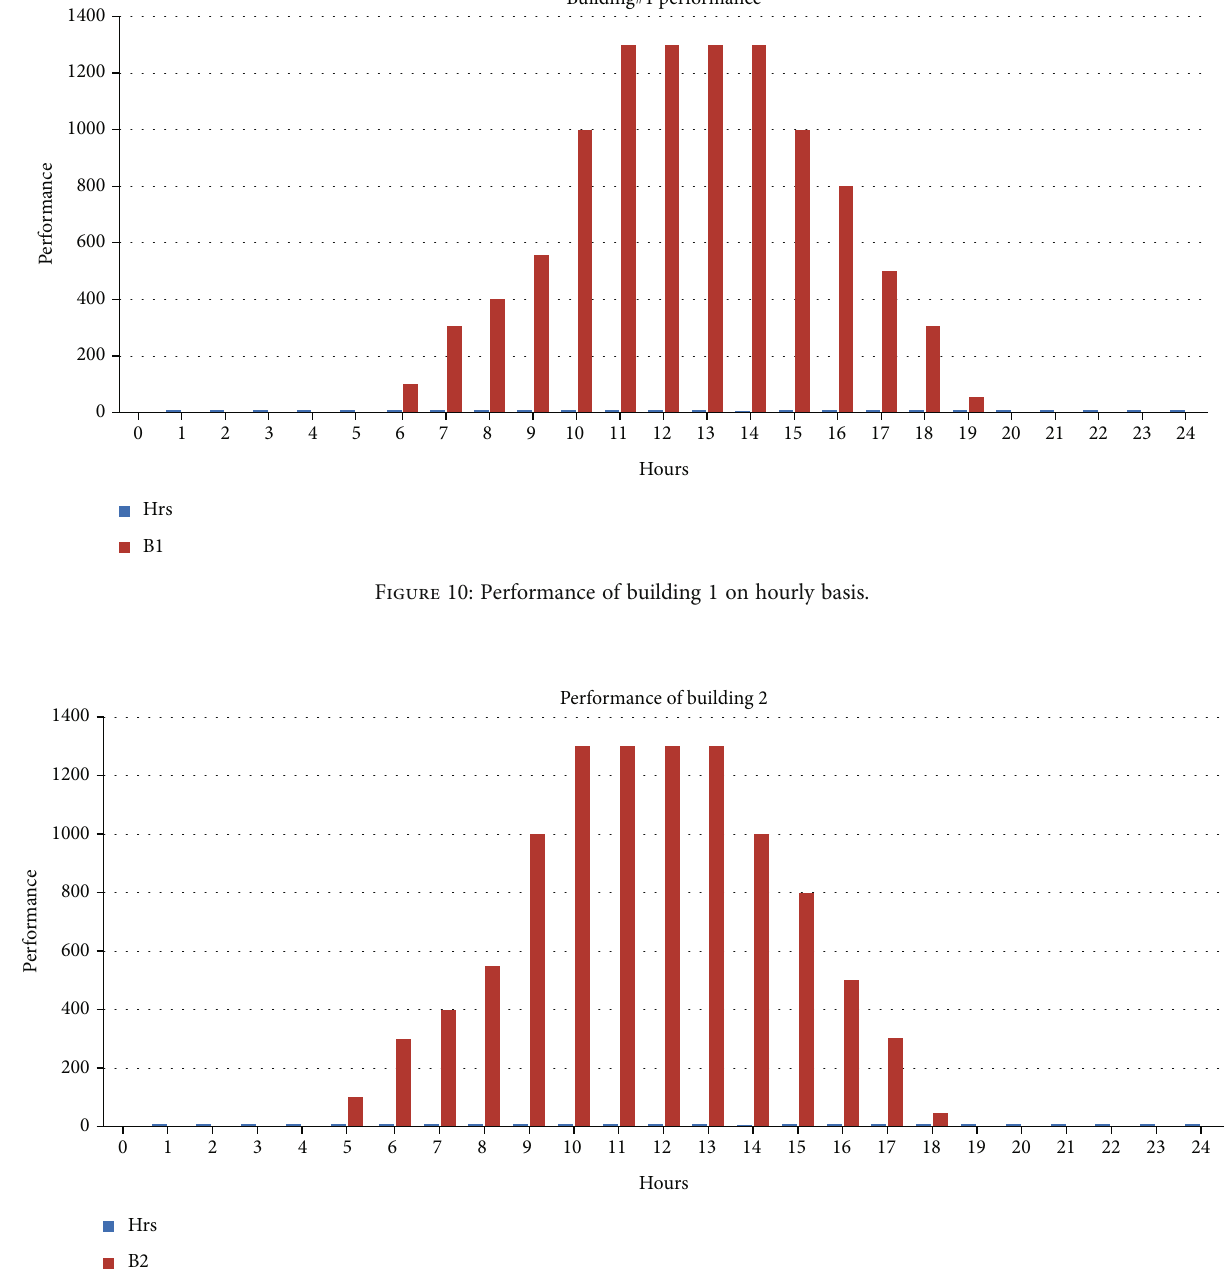
Figure 11: Performance of building 2 on hourly